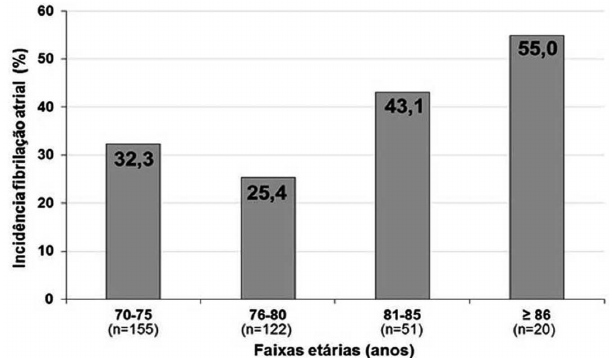
Fig. 2 – Relationship between age and acute postoperative AF after aortic stenosis surgery. Borderline statistical significance for linear trend (P=0.055). Incidência fibrilação atrial = Incidence of atrial fibrillation. Faixas etárias (anos) = Age